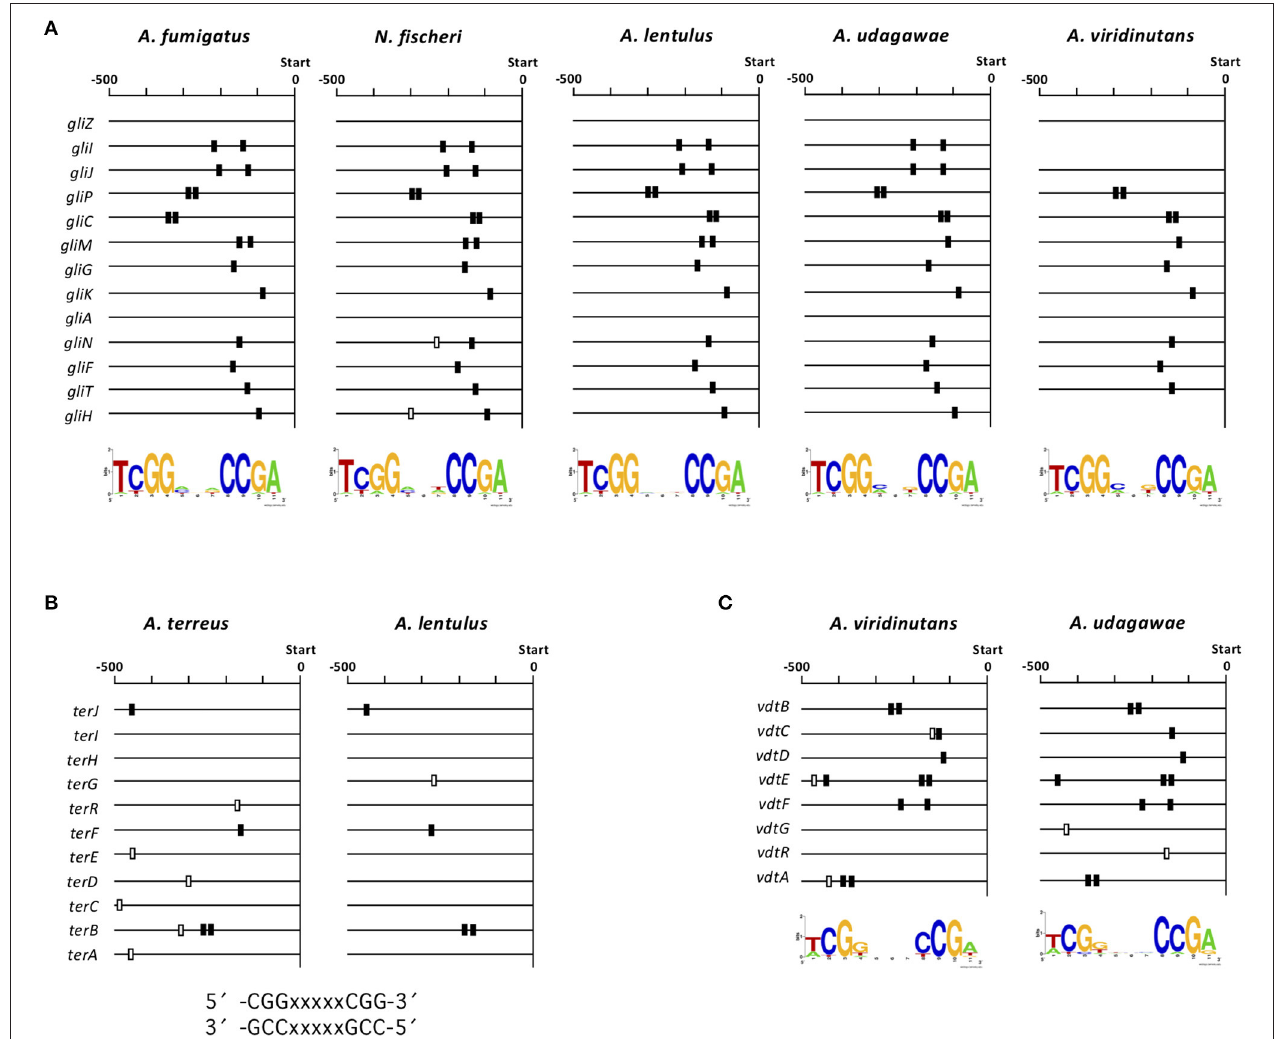
FIGURE 8 | Consensus sequences in the promoter regions of gli , ter , and vdt genes. (A) The consensus sequences were detected in the 13 gli genes in each species using BioProspector (Release 2), and the top hit motifs are shown under the map. The position of the sequence (TCGG NNNCCGA) is indicated by a box. The black boxes indicate consensus sequences that were considered to correspond to those in the other species tested. (B) Consensus sequences were sought in the 11 ter genes in A. lentulus and A. terreus by manual inspection. The positions of the reported consensus sequences (CCGNNNNNCCG and CGGNNNNNCGG) in the cluster is indicated by black or white boxes. (C) Consensus sequences were detected in the eight vdt genes in A. viridinutans and A. udagawae using BioProspector (Release 2), and the top hit motifs are shown under the map. Positions of the sequence (TCGGNNNCCGA) are indicated by black or white boxes. − 500, 500-bp upstream from the translational initiation site of each